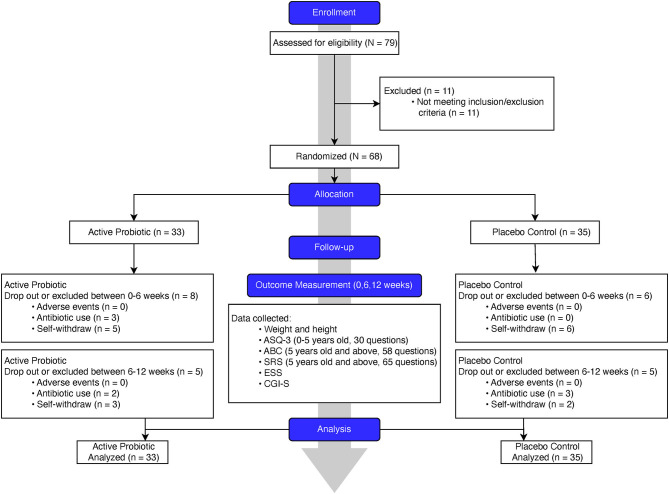
Flowchart of study conduct and procedure.